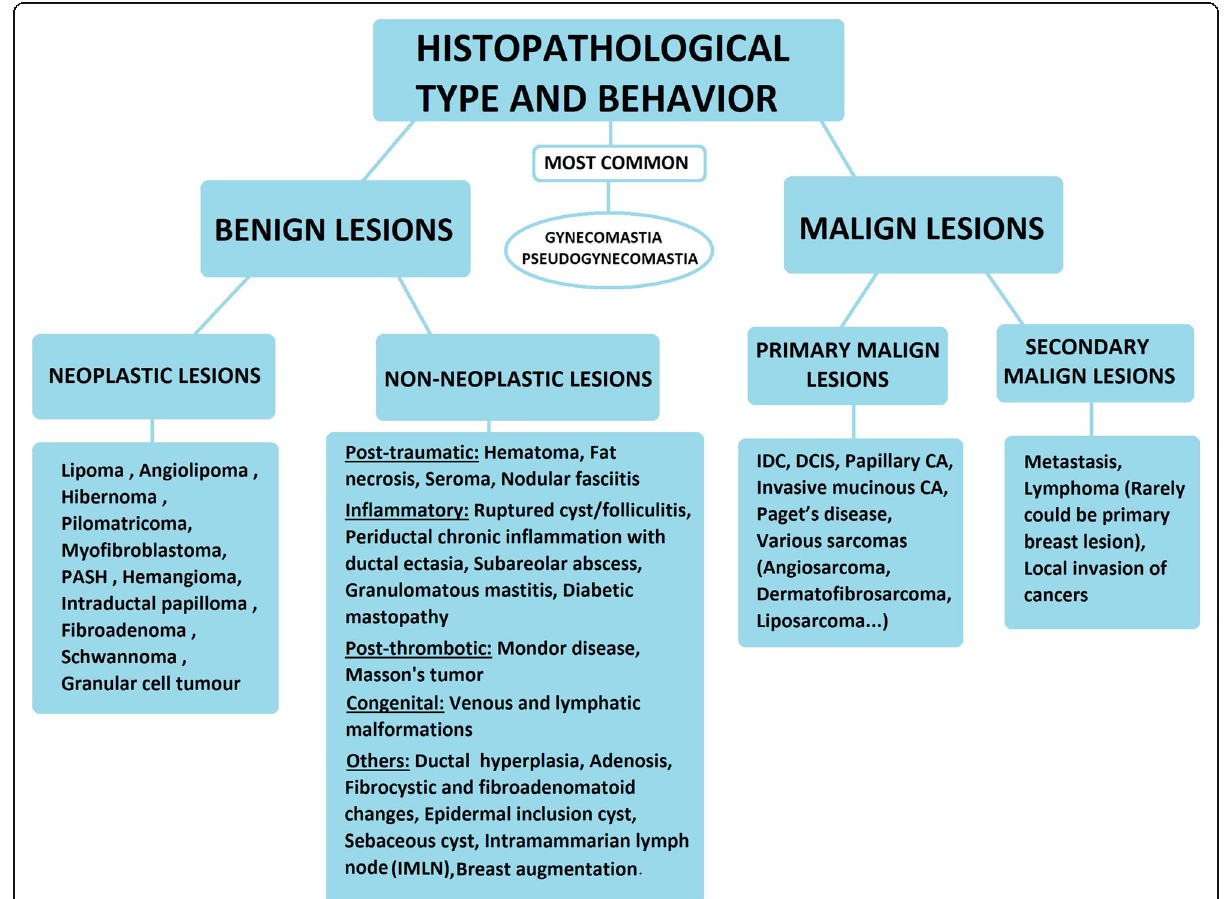
Fig. 7 Classification based on “ Histopathological type and behavior